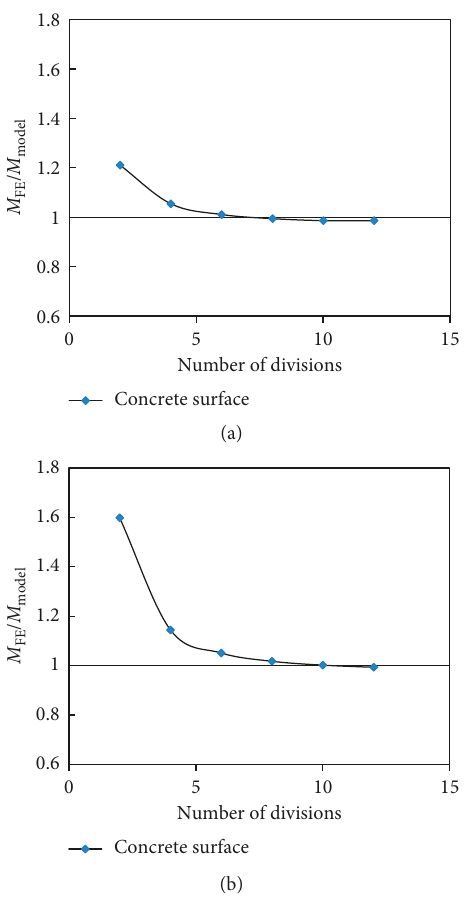
Figure 4: Sensitivity analysis for number of division effect on the result of the end moments. End moment at (a) End 1 due to ro- tation at End 1 and (b) End 2 due to rotation at End